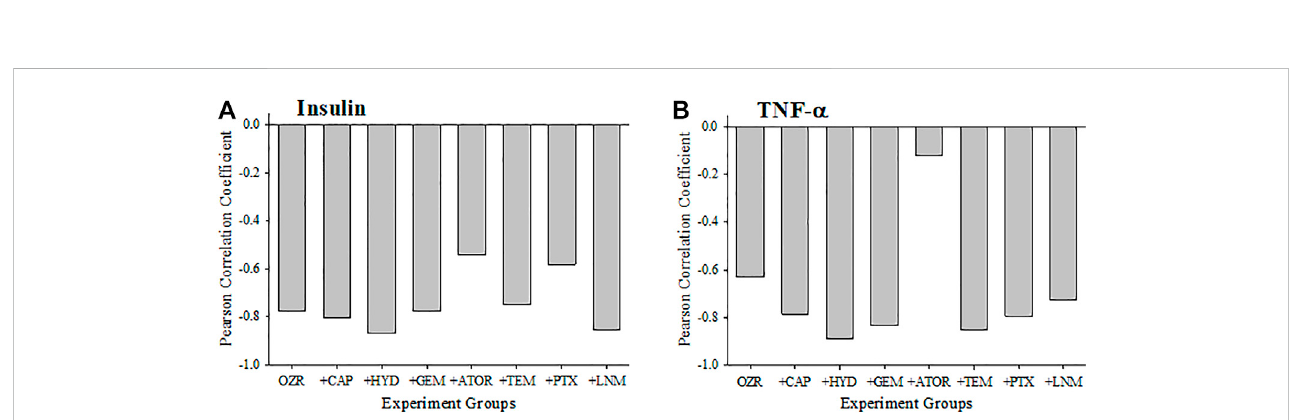
FIGURE 3 Data (mean ± SE) describing the criterion validity between plasma insulin (A) or TNF- α (B) and the skeletal muscle Vascular Health Index (VHI) across the different treatment groups in the present study. Criterion validity is demonstrated by a strong, negative Pearson Correlation coef fi cient between insulin or TNF- α and VHI in OZR. Please see text for